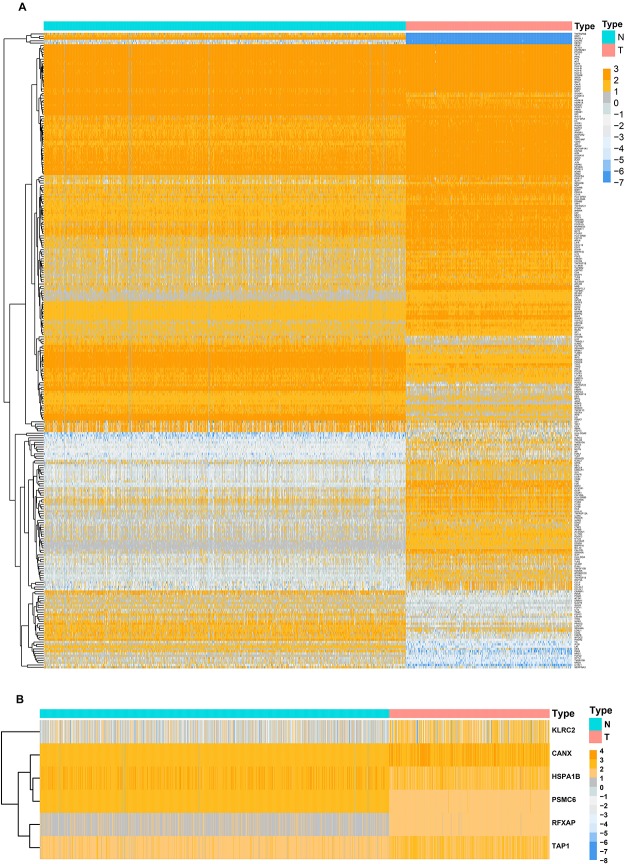
Heatmaps of differentially expressed genes between normal tissue and lower-grade glioma. (A) Heatmap demonstrating the differential expressed 277 immune-related genes. (B) Heatmap demonstrating the differential expressed six immune-related risk genes.